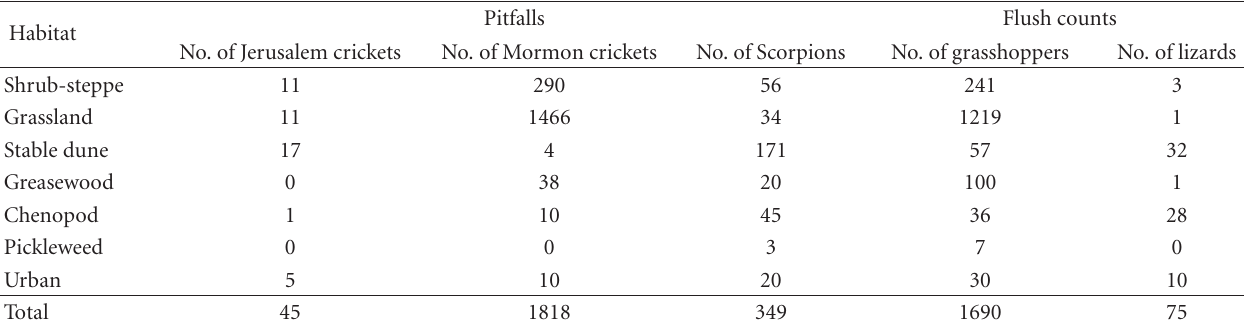
Table 2: Abundance and distribution of prey species recorded during pitfall trapping and flush counts on Dugway Proving Ground, Utah,